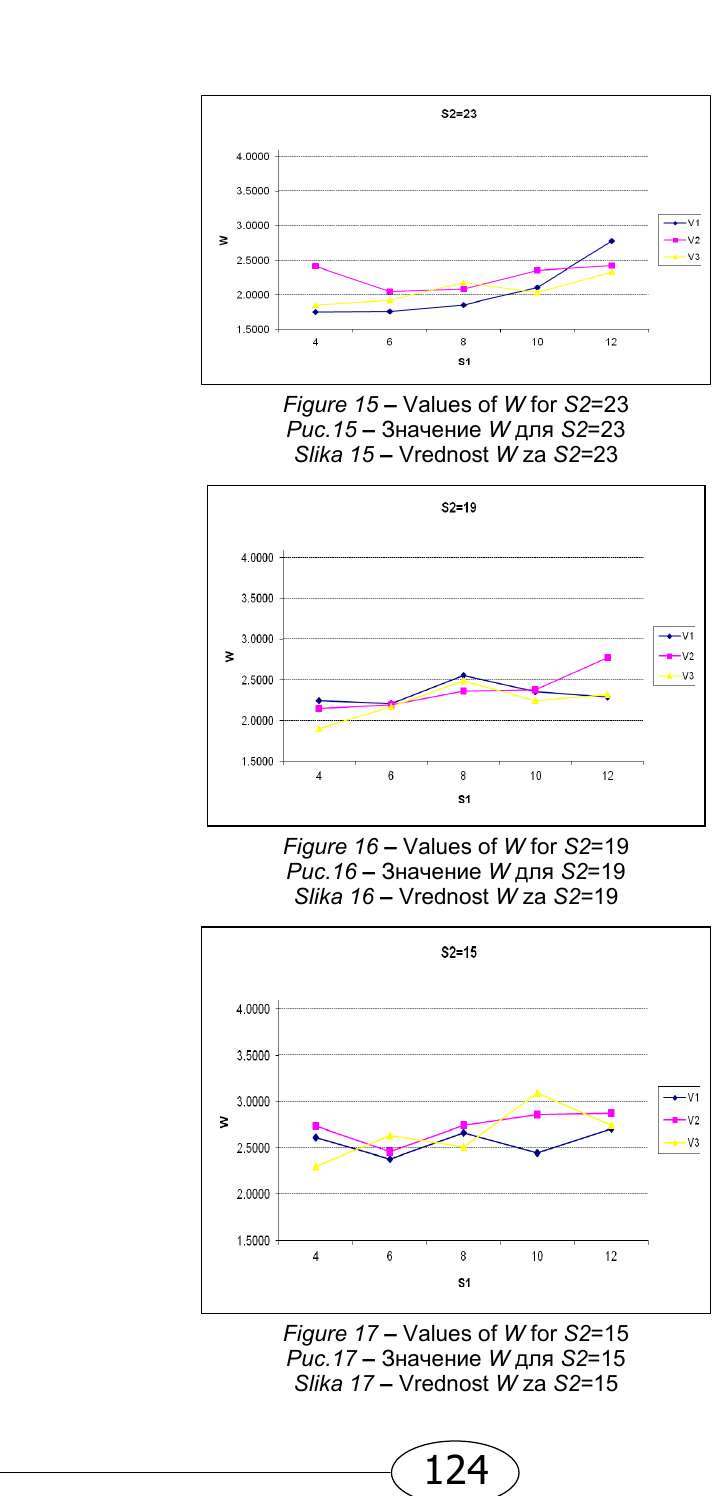
Figure 17 – Values of W for S2 =15 Рис .17 – Значение W для S2